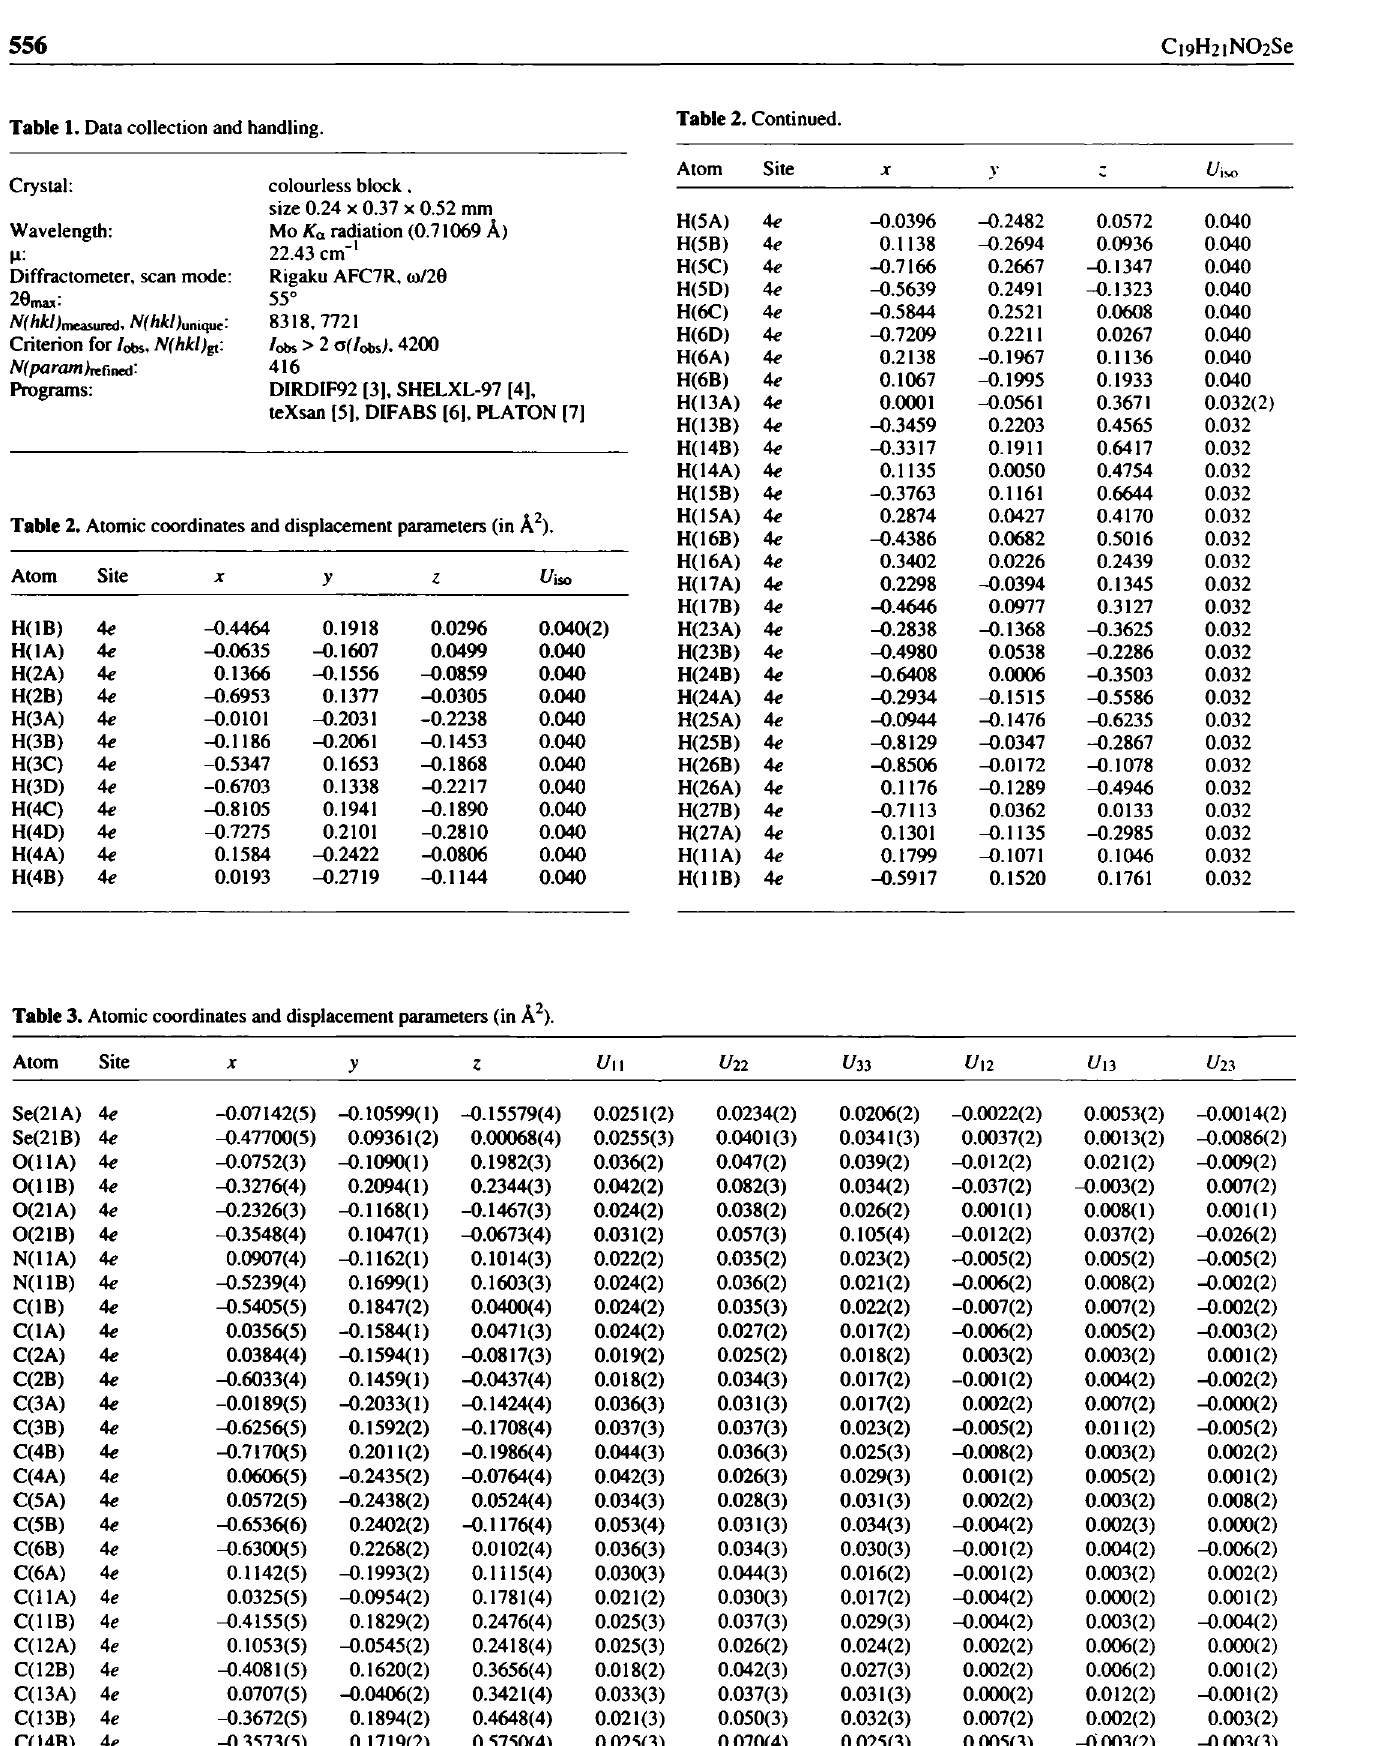
Table 3. Atomic coordinates and displacement parameters (in A 2